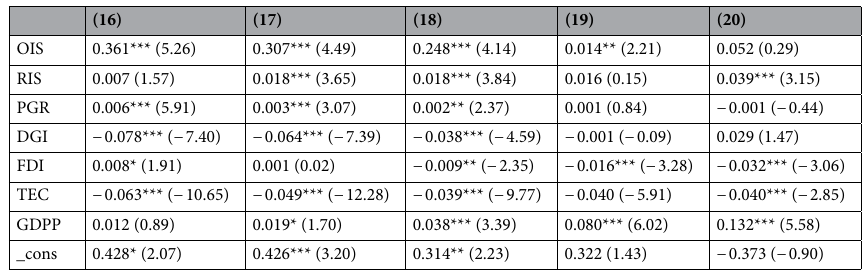
Table 7. Quantile regression results. * p < 0.1, ** p < 0.05, *** p < 0.01; the bracket represents the t value.